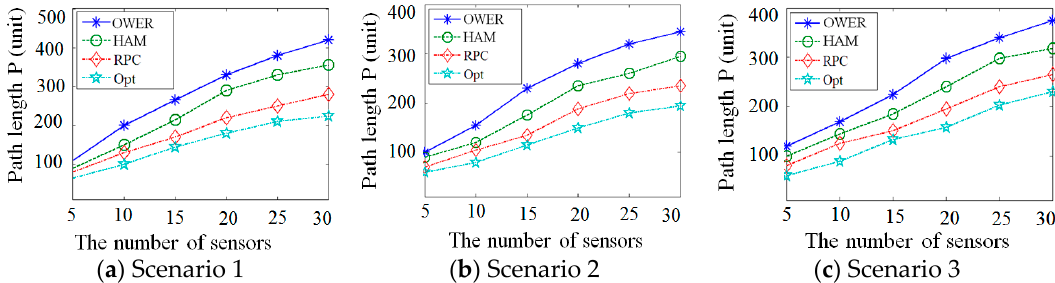
Figure 11. The comparison of four recharging mechanisms in terms of path length using different deployment scenarios.